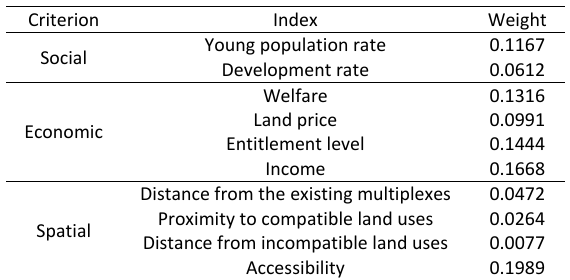
Table 5: Final results of Fuzzy AHP Method in weighting indices